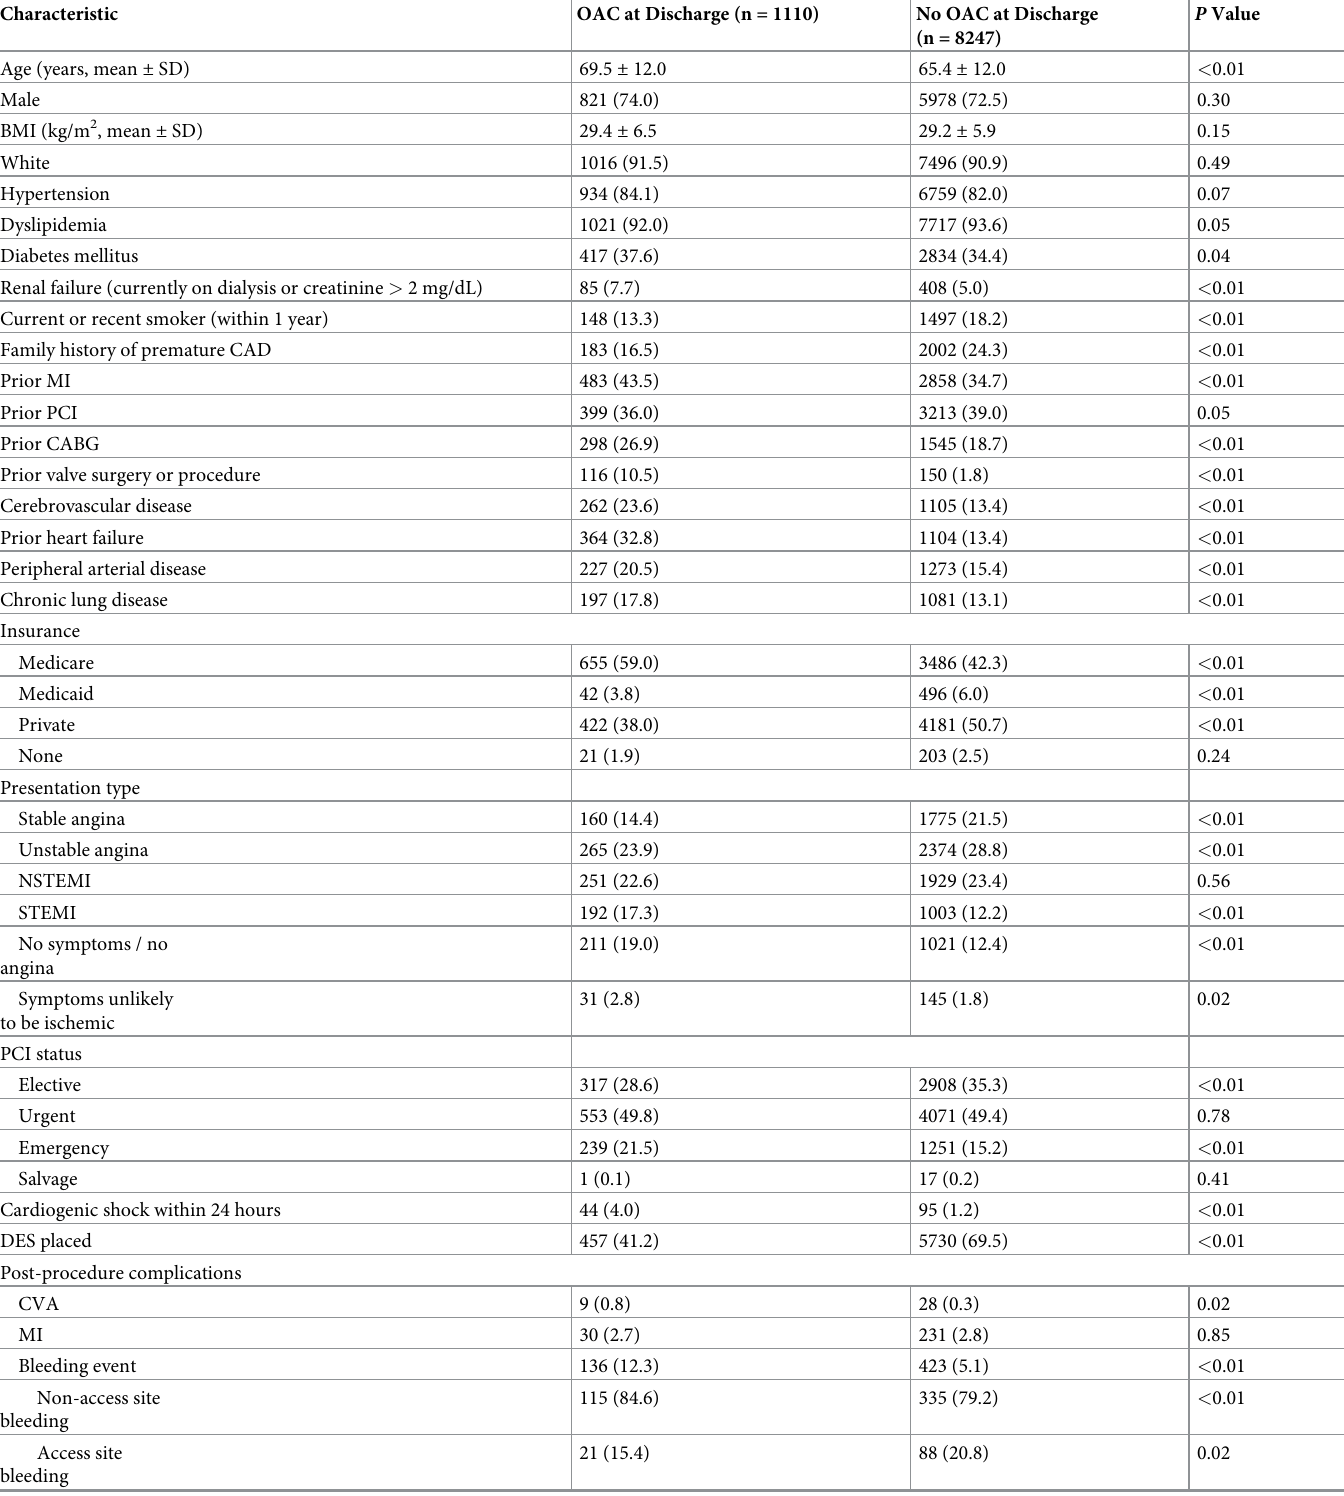
Table 1. Baseline and procedural characteristics of all patients discharged after percutaneous coronary intervention (PCI), stratified by discharge OAC status.